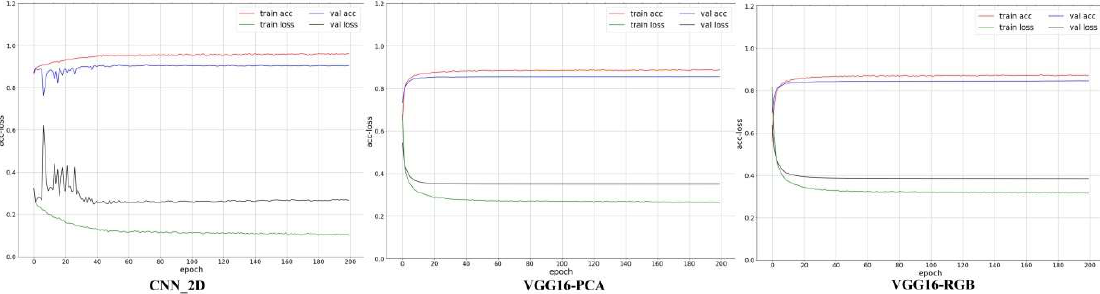
Figure 13. Accuracy and loss in the training process of the proposed CNN_2D, VGG16-PCA, and VGG16-RGB. Table 10. The accuracy and loss of CNN_2D, VGG16-PCA, and VGG16-RGB.